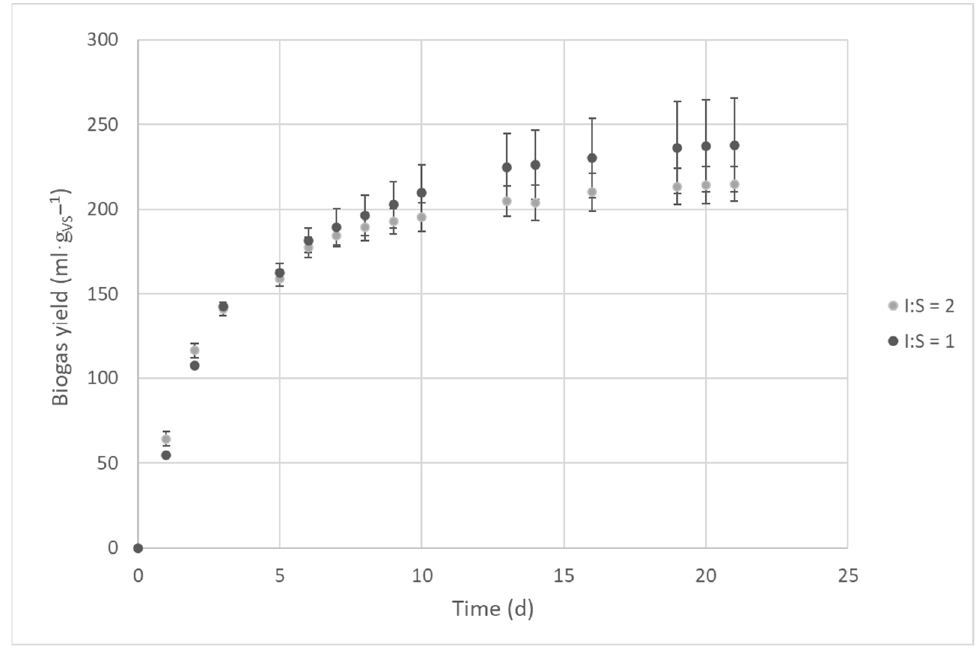
Figure 1. Biogas production during the process, with different inoculum to sludge ratios.